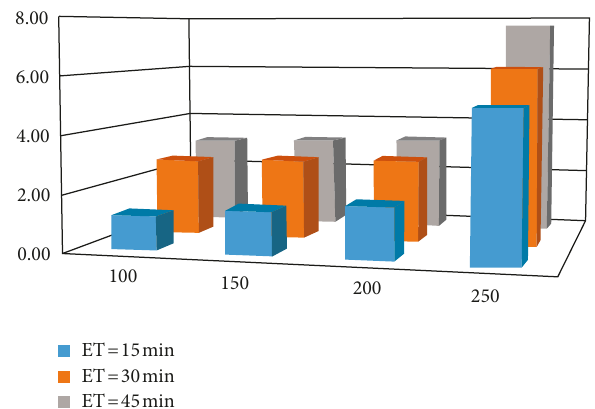
Figure 7: Weight loss rate of specimens using the natural cooling method in Test 1 (“ET” indicates the exposure time).